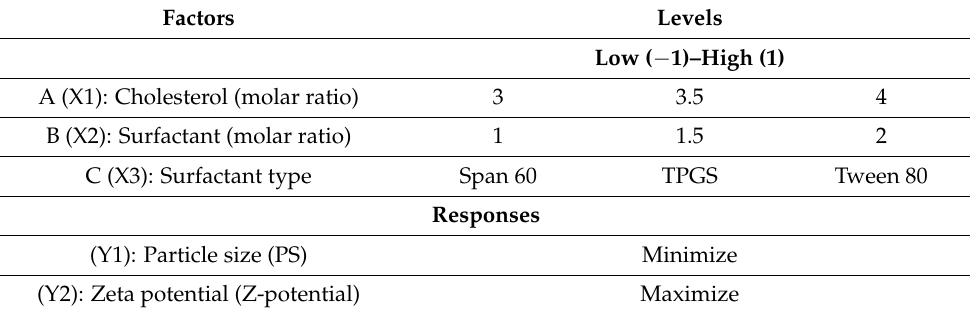
Table 5. Factorial design of drug-free niosomes composition.